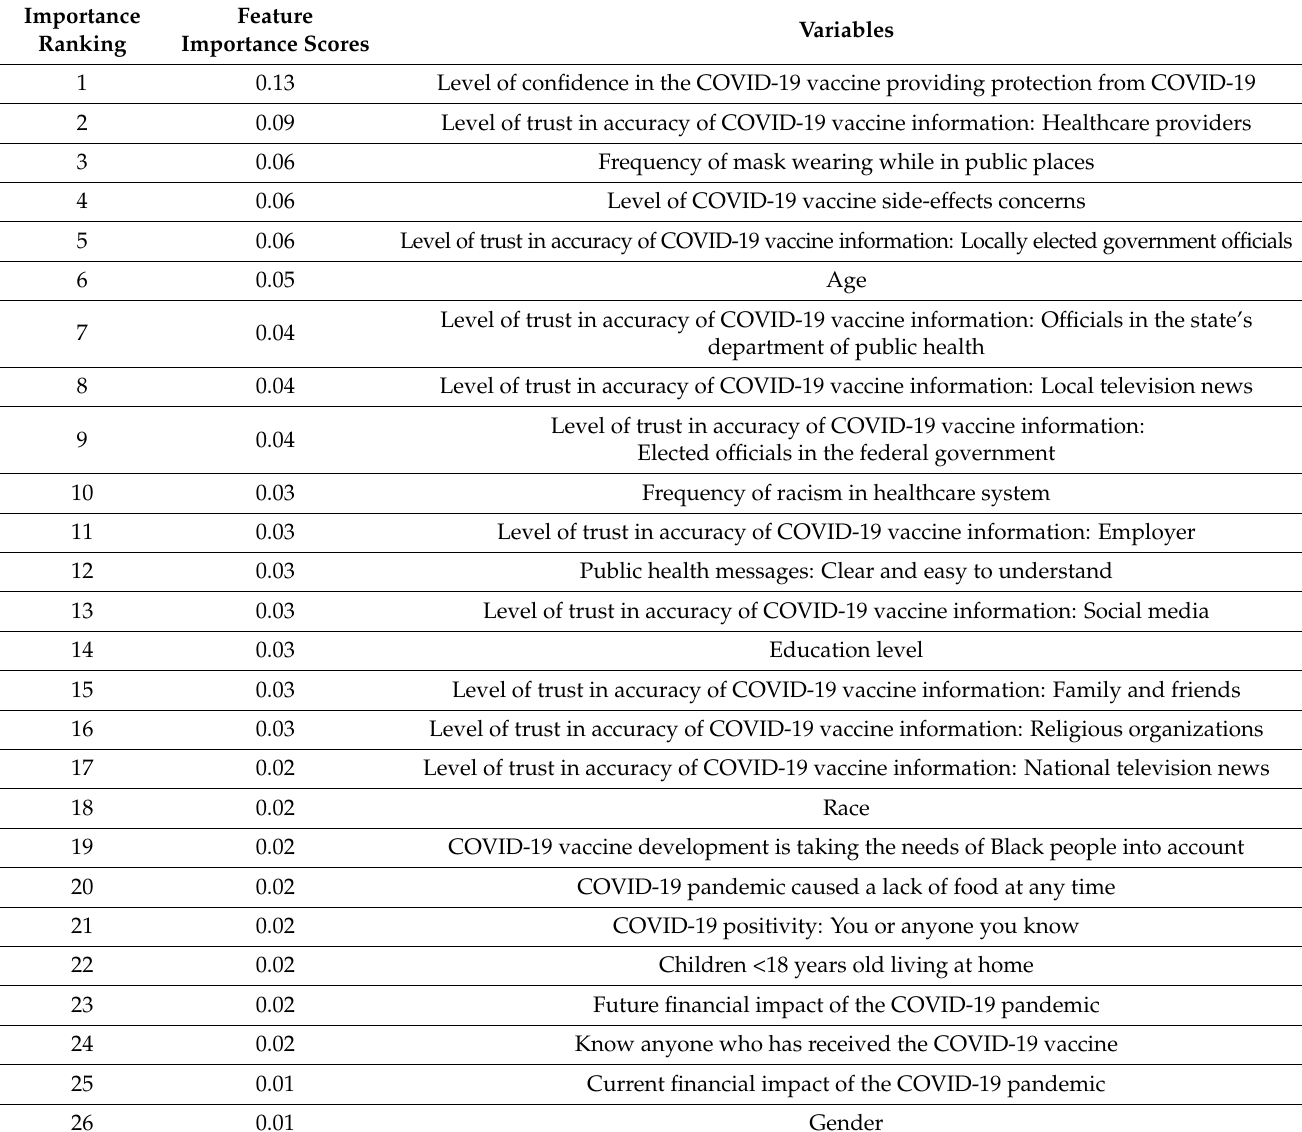
Table 2. Feature Importance Analysis: Ranking of Variables with Important Features of Predicting COVID-19 Vaccination